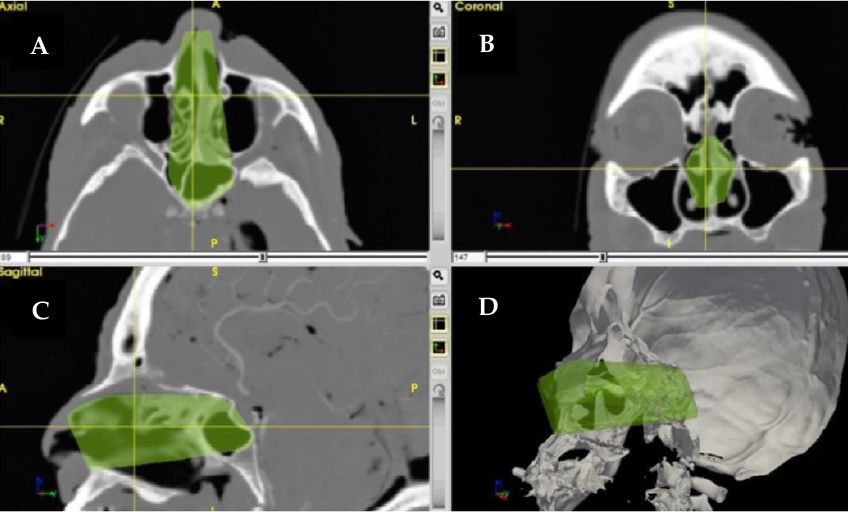
Figure 1. Rendering of the surgical pyramid in ( A ) axial, ( B ) coronal, ( C ) sagittal sections, and ( D ) 3D rendering for the endoscopic trans-rostral trans-sphenoidal approach.